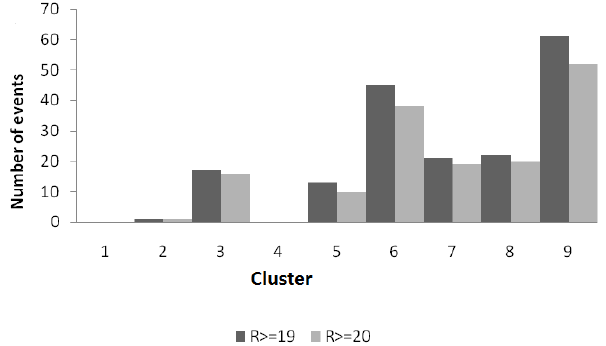
Fig. 4. Allocation of heavy rainfall events in the 9-cluster classification.